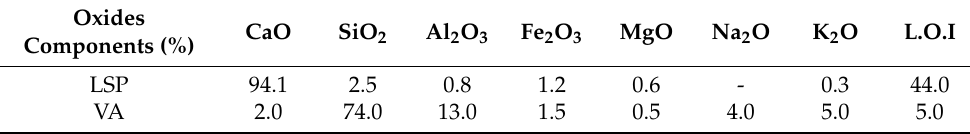
Table 1. Chemical constituents of raw volcanic ash powder and limestone